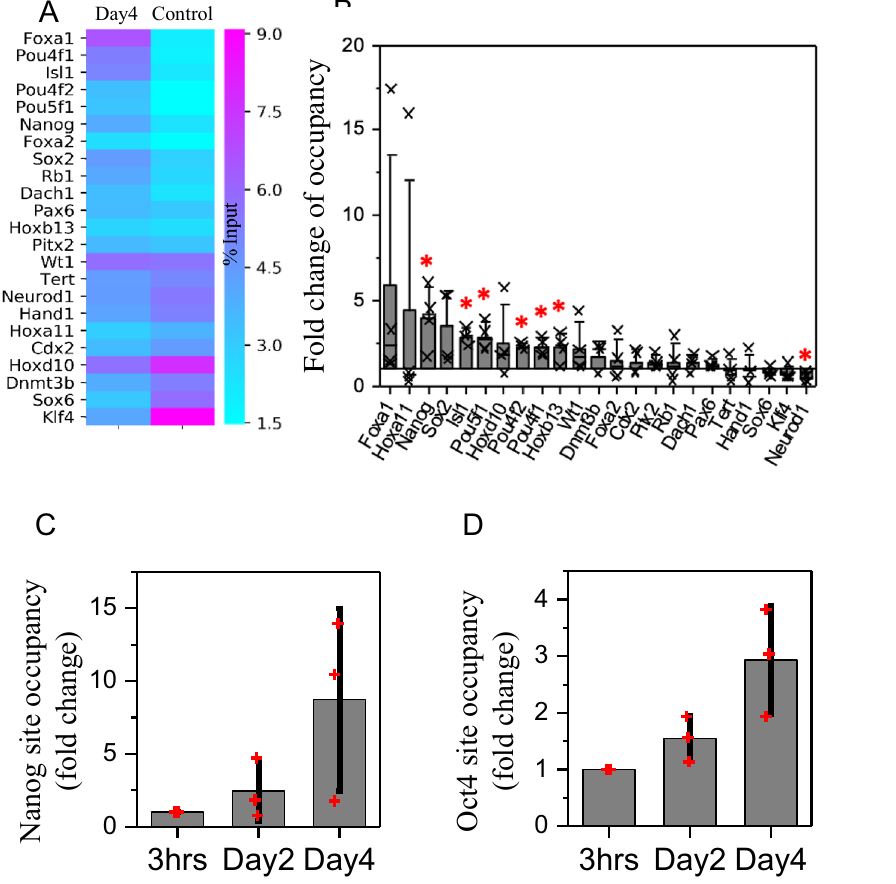
Figure 4. Lef1 binds to the gene loci of the reprogramming factors during the mechanically induced fibroblast de-differentiation. ( A ) The heatmap shows binding of Lef1 to the promoter regions of selected genes in Day4. Control cells grown on 2D culture are also shown. The unit is percentage of input. ( B ) Fold change of Lef1 promoter occupancy comparing Day4 sample to control sample. * P < 0.05. (C/D) The bar plot shows the increase of binding of Lef1 to Nanog and Oct4 promoter regions at 3 h, Day2 and